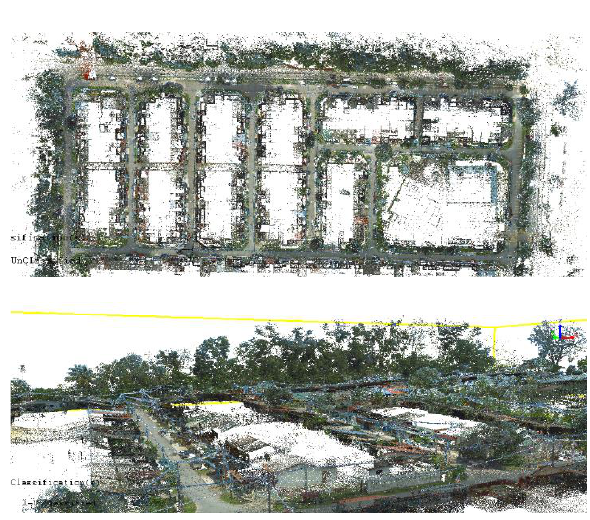
Figure 3 . The result for Mobile LiDAR Data Acquisition